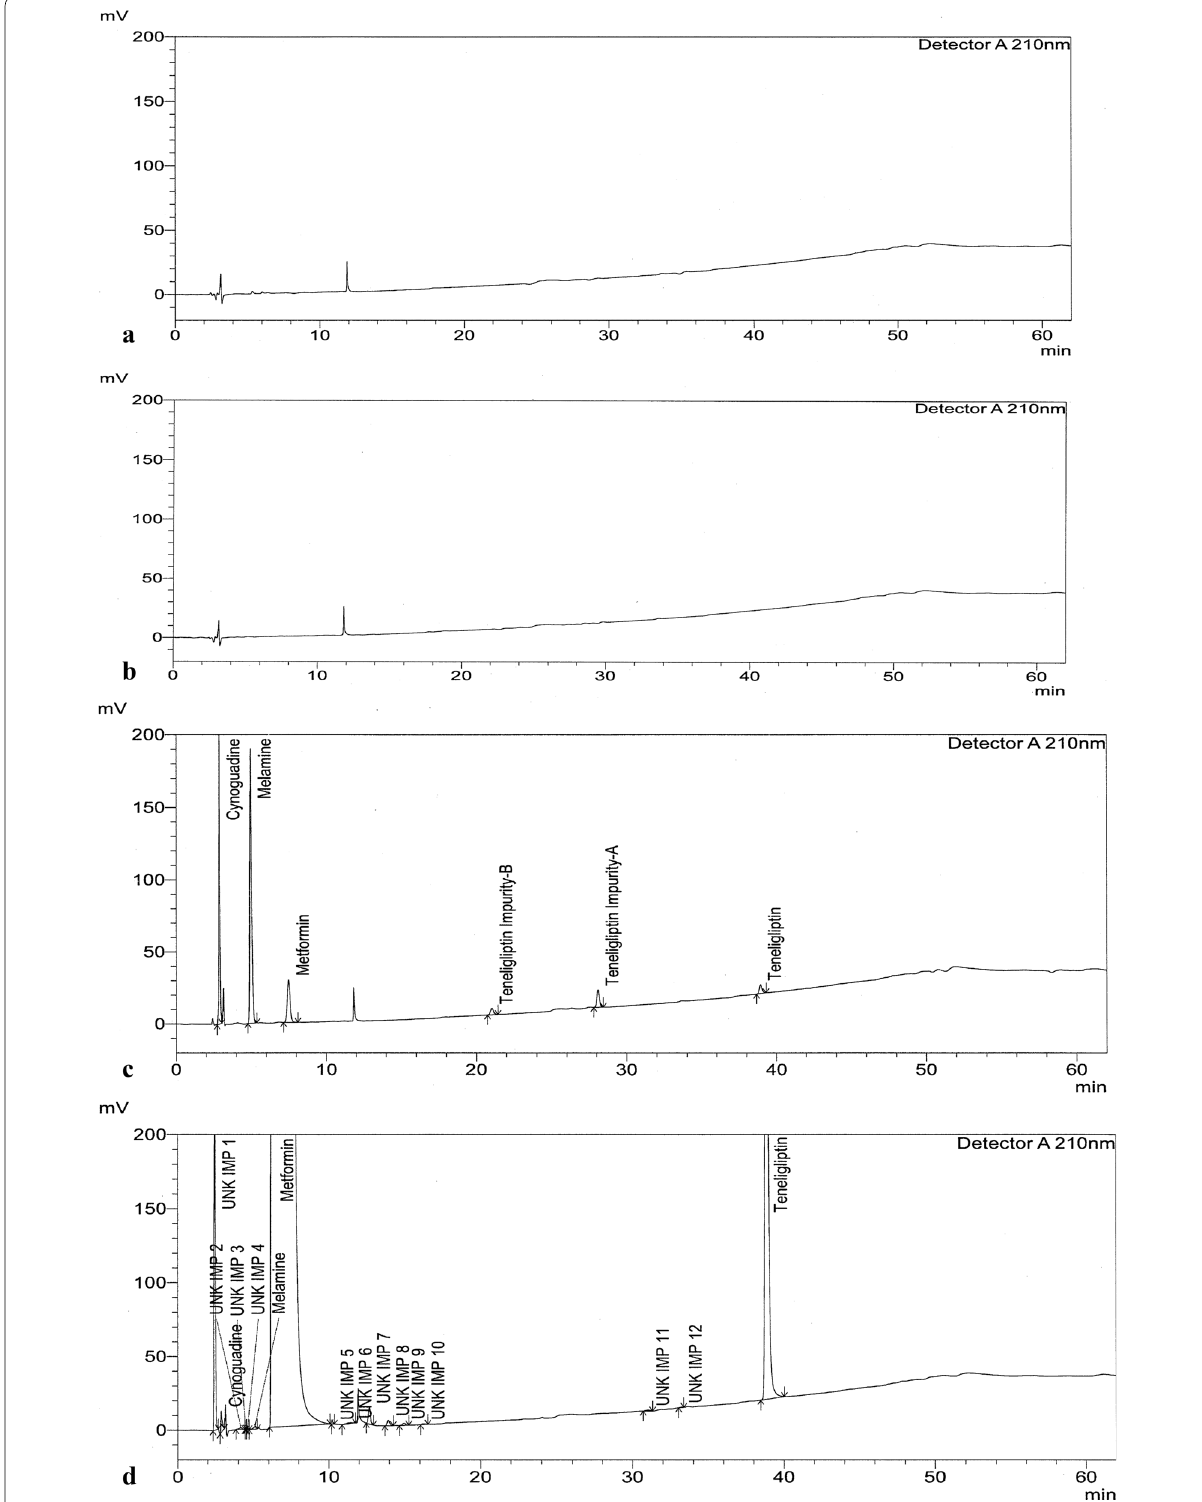
Fig. 2 a Representative chromatogram of blank solution. b Representative chromatogram of placebo solution. c Representative chromatogram of system suitability solution. d Representative chromatogram of sample